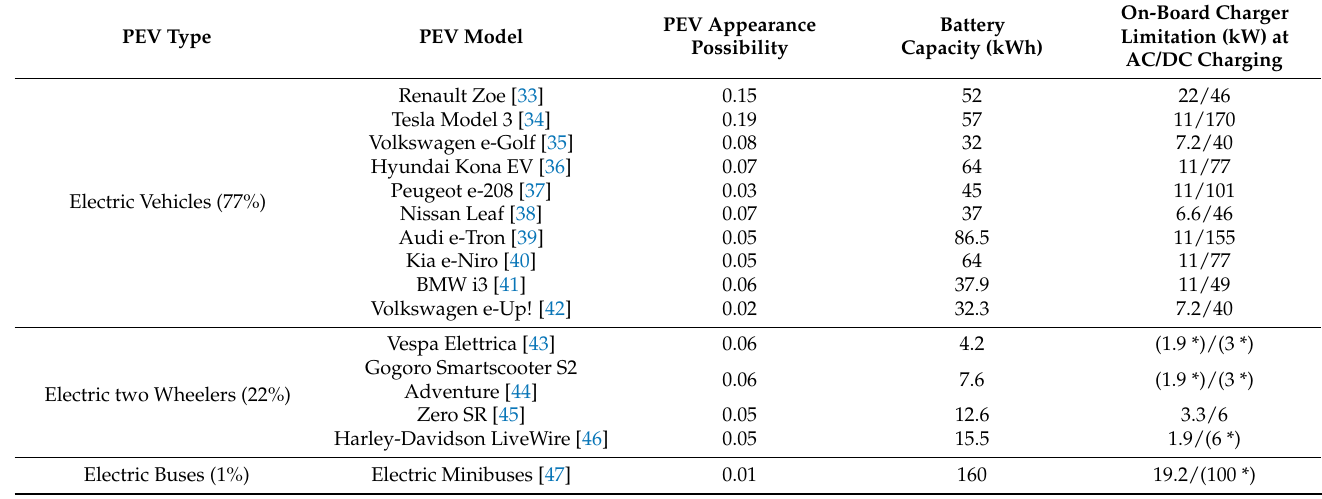
Table 1. PEV model, arrival possibility, battery capacity and on-board charger limitation at AC